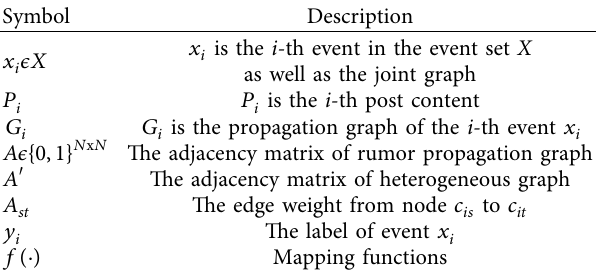
Table 1: Symbols used in this